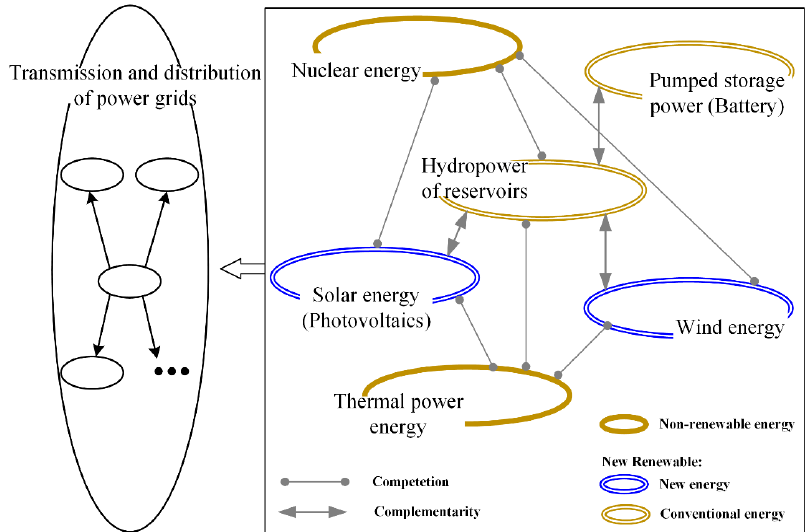
Figure 2. Schematic of the grid-connected hybrid energy system.